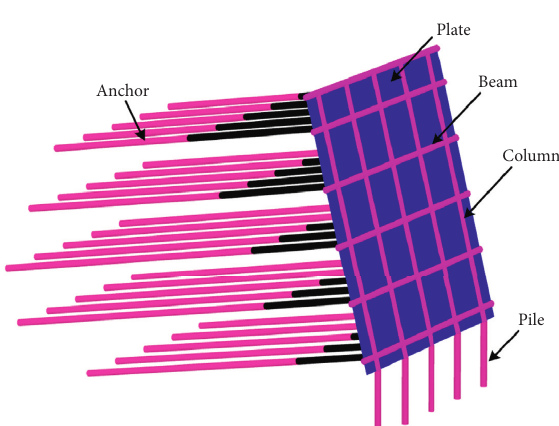
Figure 6: Structure model.